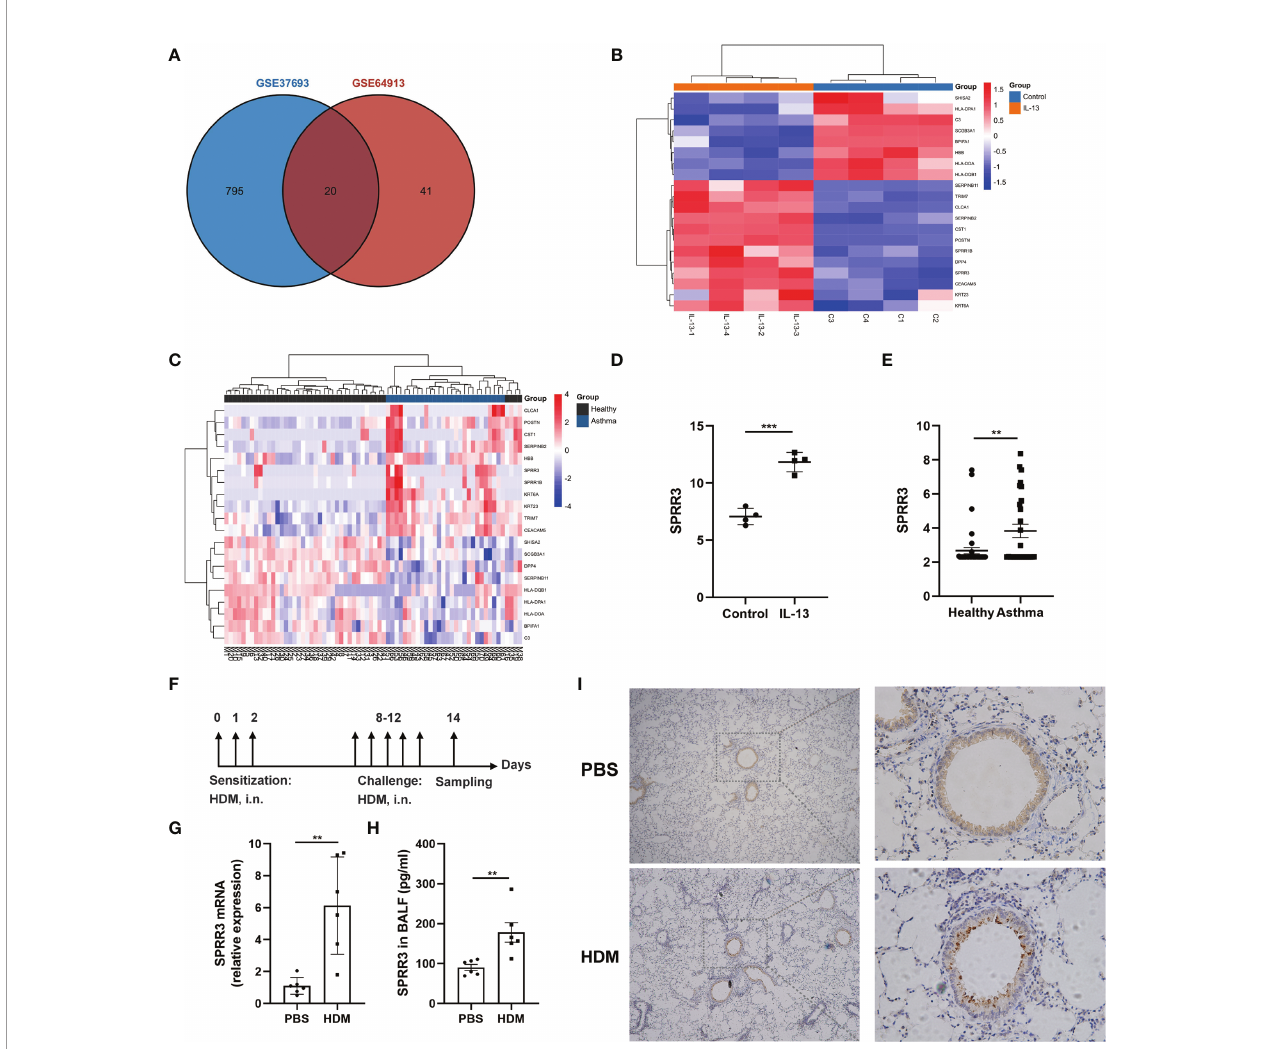
FIGURE 1 | Screening and con fi rmation of differentially expressed genes (DEGs). (A) Venn diagram indicating the intersection of DEGs in datasets GSE64913 and GSE37693. (B) Heatmap of candidate DEGs in the GSE37693 dataset. Red represents upregulated DEGs, and blue represents downregulated DEGs. (C) Heatmap of candidate DEGs in the GSE64913 dataset. Red represents upregulated DEGs, and blue represents downregulated DEGs. (D) The expression of SPRR3 in airway epithelial cells treated with IL-13. (E) The expression of SPRR3 in asthmatic bronchial epithelial cells. (F) Schematic of the house dust mite (HDM)-induced asthmatic mouse model. (G) The mRNA expression of SPRR3 in lungs of HDM-induced mice. (H) The protein level of SPRR3 in bronchoalveolar lavage fl uid (BALF) determined by ELISA. (I) Immunohistochemistry staining of the lung to assess the expression of SPRR3. Original magni fi cation, ×200. Values represent mean ± SEM, n = 4 – 6 for each group. ** p < 0.01, *** p <